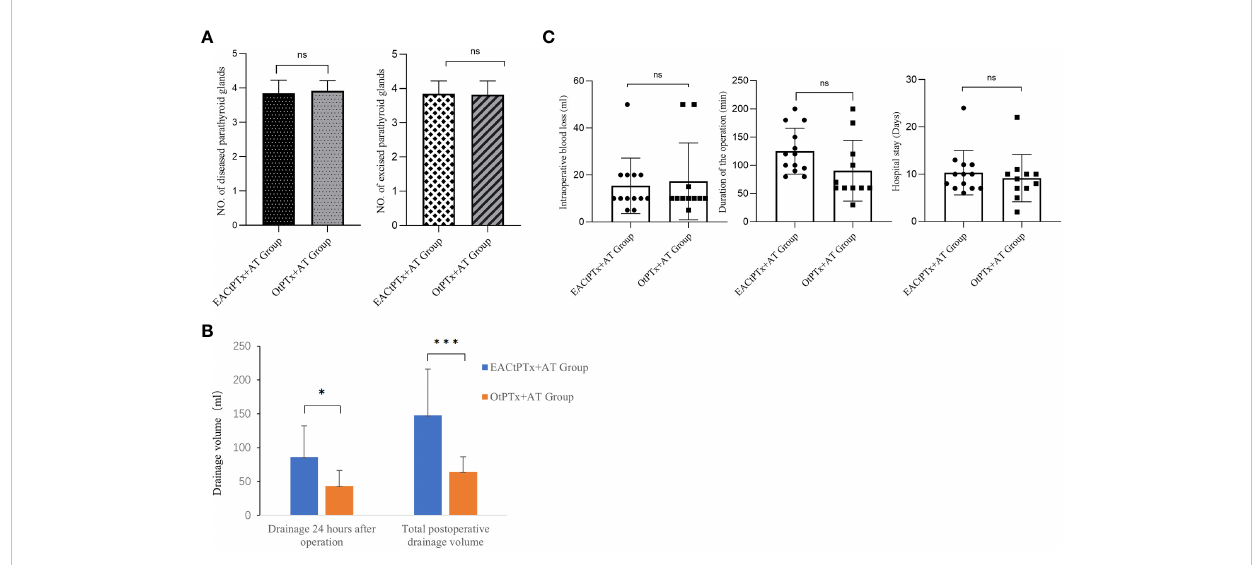
FIGURE 5 Surgery-related indicators in two groups. (A) Comparison of number of diseased and excised parathyroid glands between the two groups. (B) Comparison of drainage volume between the two groups. (C) Comparison of Duration of the operation. Intraoperative blood loss. Hospital stay between the two